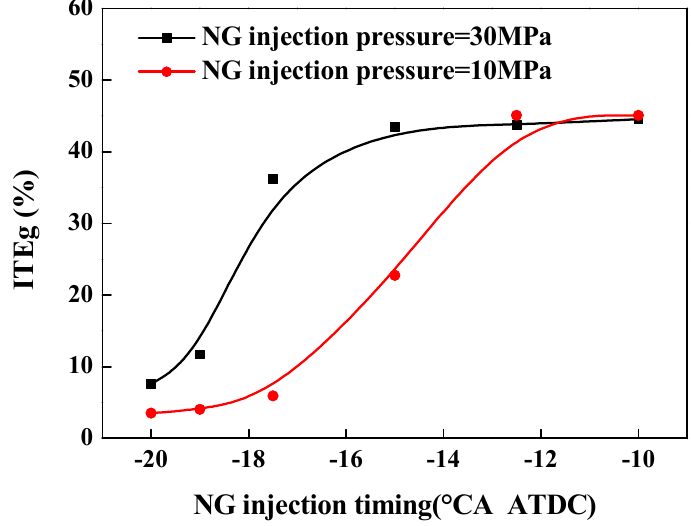
Figure 18. Variation of ITEg and NG injection timing.